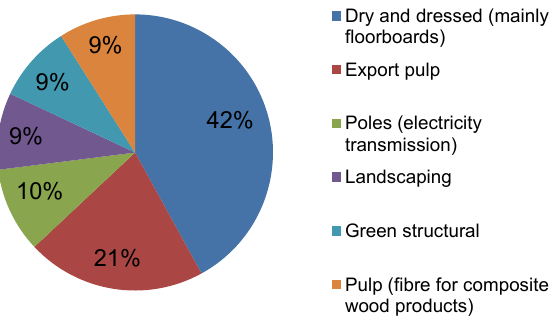
Figure 6. Product mix obtained from the North Coast “ production ” forests.